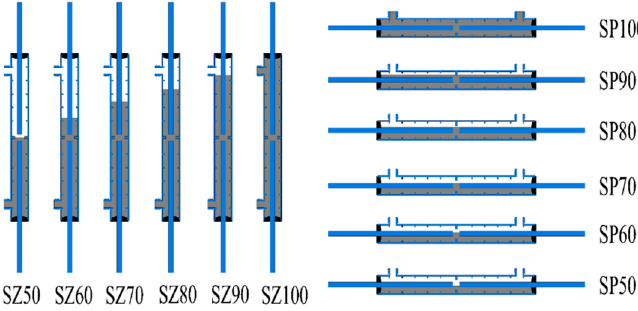
Figure 1. Schematic diagram of each saturation sleeve. Table 1. Main technical indexes of specimens.